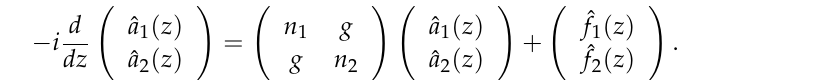
-symmetry regime with balanced PT